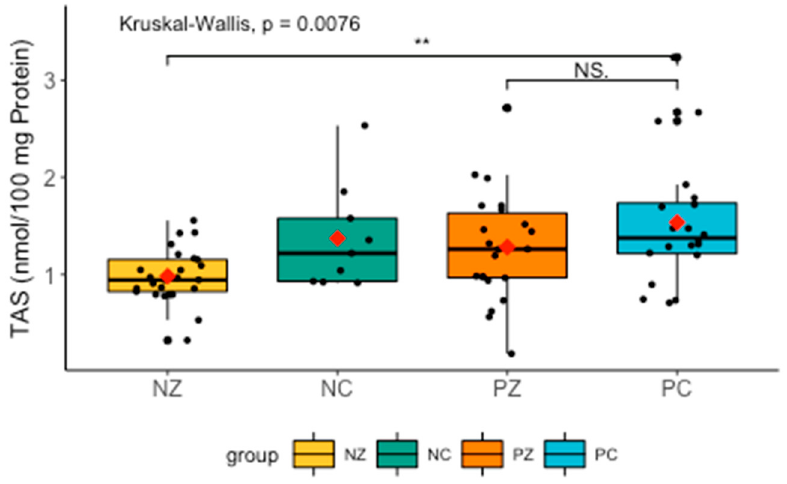
Figure 1. Levels of TAS in the saliva of the examined women. TAS, total antioxidant status; NZ, generally healthy patients without the BRCA1 mutation; NC, patients with breast cancer but without the BRCA1 mutation; PZ, generally healthy patients with the BRCA1 mutation; PC, patients with both breast cancer and the BRCA1 mutation. ** p < 0.01.